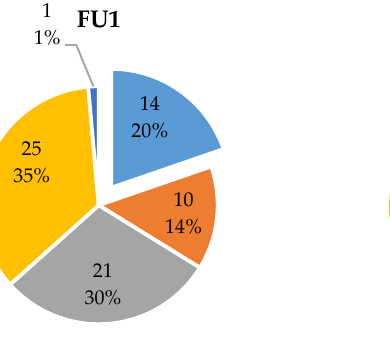
Figure 2. Reduction rates at FU1 and FU2.